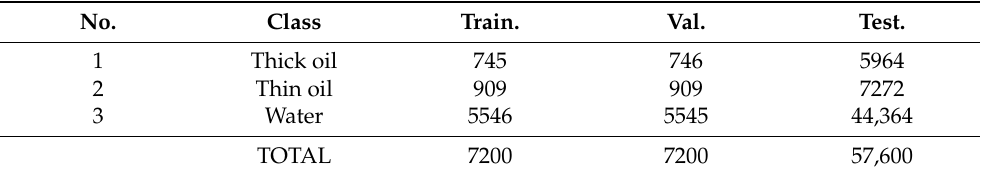
Table 4. Training, validation, and testing numbers in the dataset